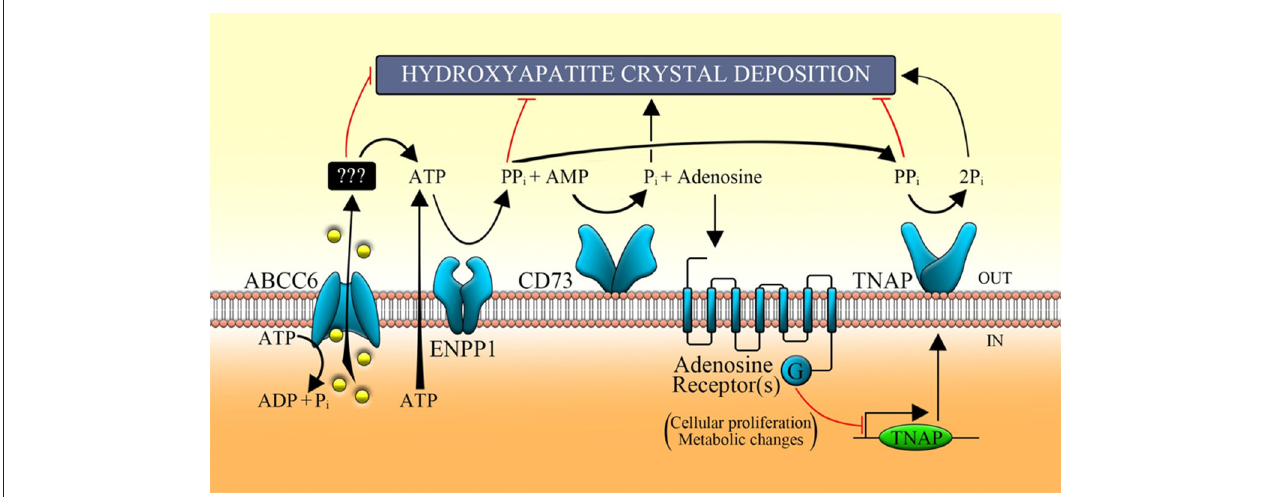
FIGURE 1 | Effects of Probenecid on viability and morphology of HepG2 cells. (A) Cells were treated with Probenecid at different concentrations (250, 500, and 1,000 µ M) for 24 and 48h. Data are expressed as a percentage of the control group and presented as the means ± SD of three replicates from three independent experiments. * p < 0.05, *** p < 0.001, Student’s t -test. (B) Representative images of Probenecid-treated HepG2 cells. DMSO-treated cells were used as control.